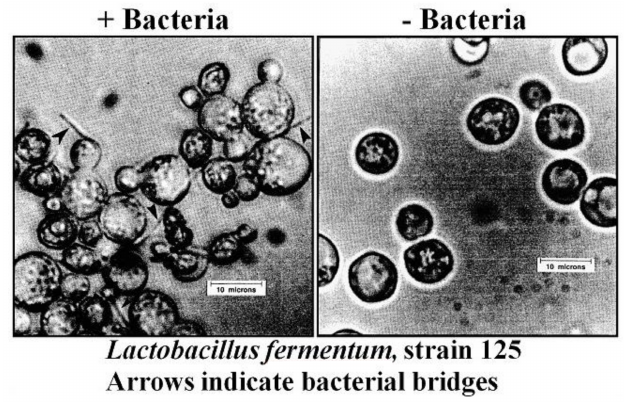
Figure 11. Co-flocculation between an ale yeast strain and a Lactobacillus fermentum strain—bacterial-induced yeast flocculation [40].